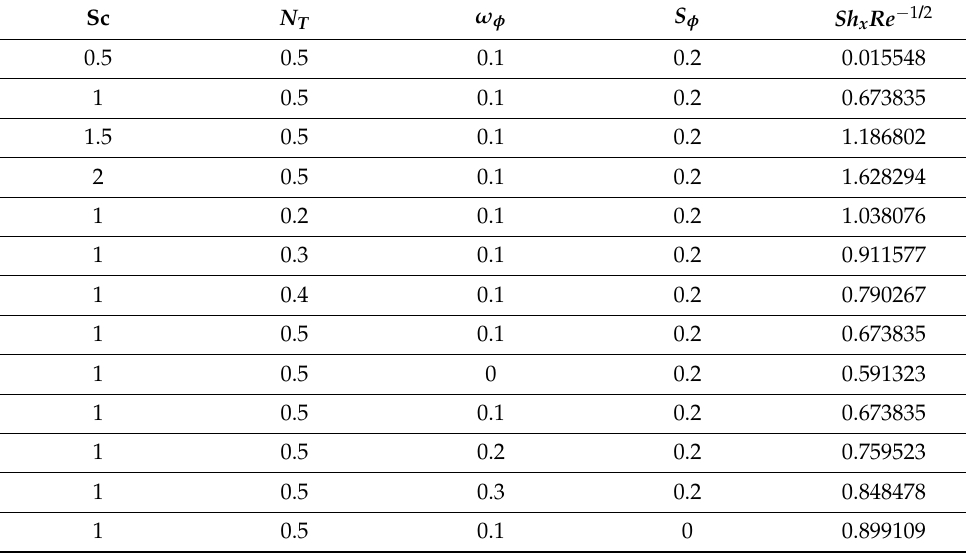
Table 4. Numerical results of Sh x Re 1/2 for different parameters Sc, N T , ω φ , and S φ